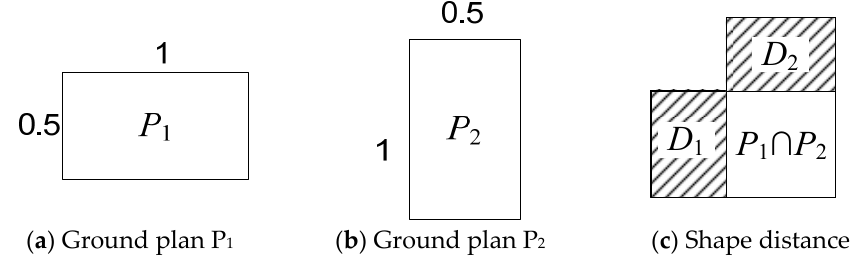
Figure 5. An example of distance between two ground plans.